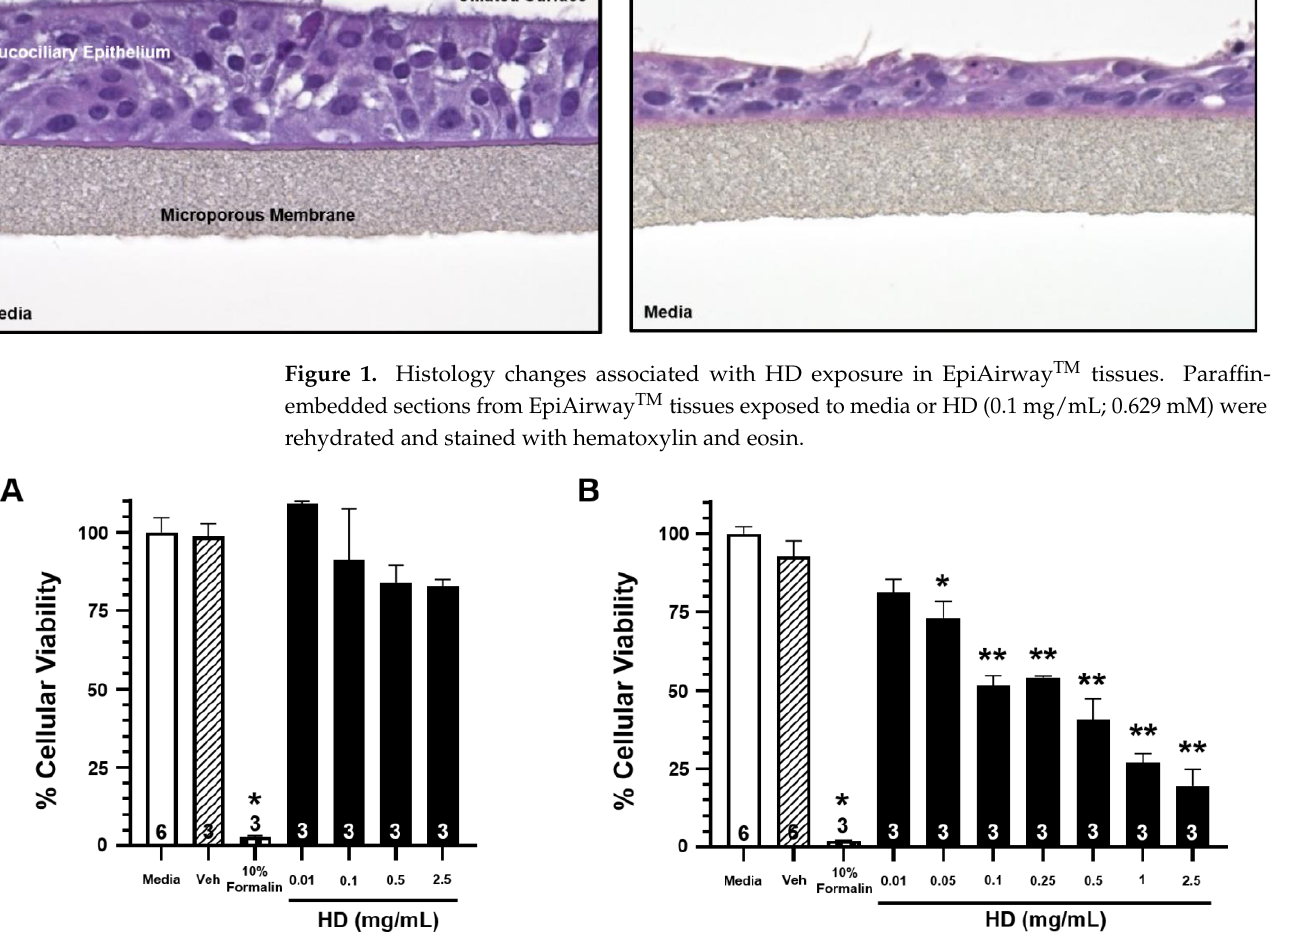
Figure 1. Histology changes associated with HD exposure in EpiAirway TM tissues. Paraffin-embed- ded sections from EpiAirway TM tissues exposed to media or HD (0.1 mg/mL; 0.629 mM) were rehy- drated and stained with hematoxylin and eosin.